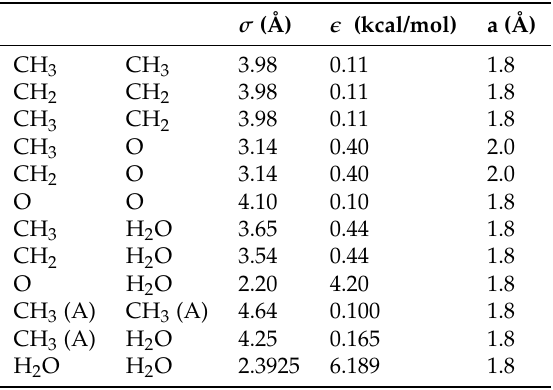
Table 1. Two-body potential parameters for ether and previously published parameters for an alkane methyl group (A) [24] and water